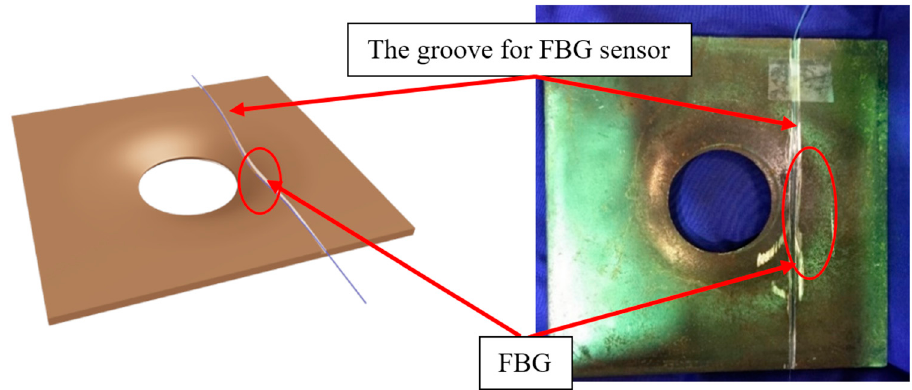
Figure 13. The load measuring anchor plate using an FBG sensor. Note: the circle indicates the location of the FBG strain sensor [46].